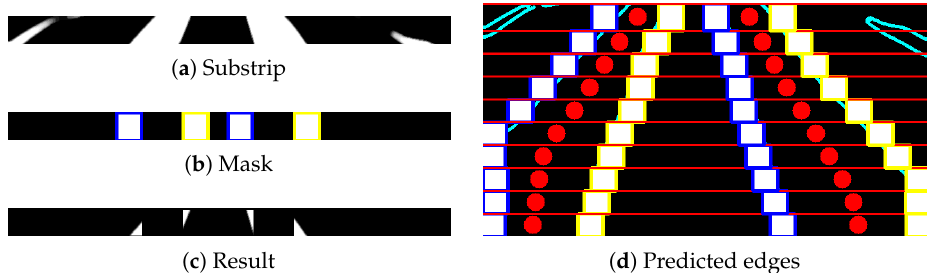
Figure 8. The figure showcases the resultant image obtained using substrip and mask that helps to find the edge of the labels. The sub-ROIs are stopped when it reaches the edges and update the label centers for each micro-ROI.